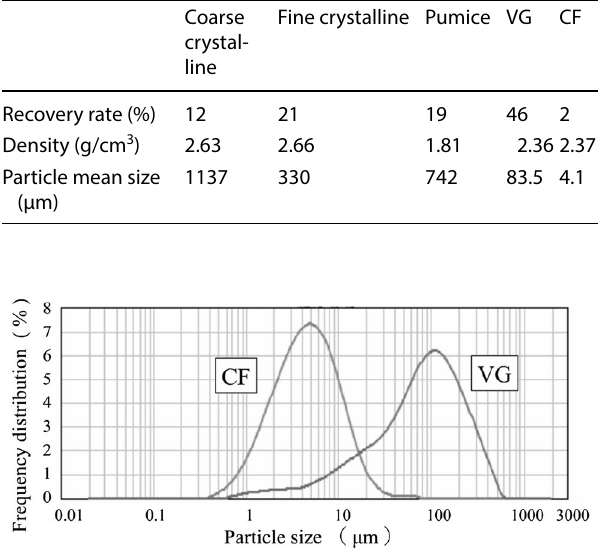
Table 1 Recovery rate, density and mean size of components